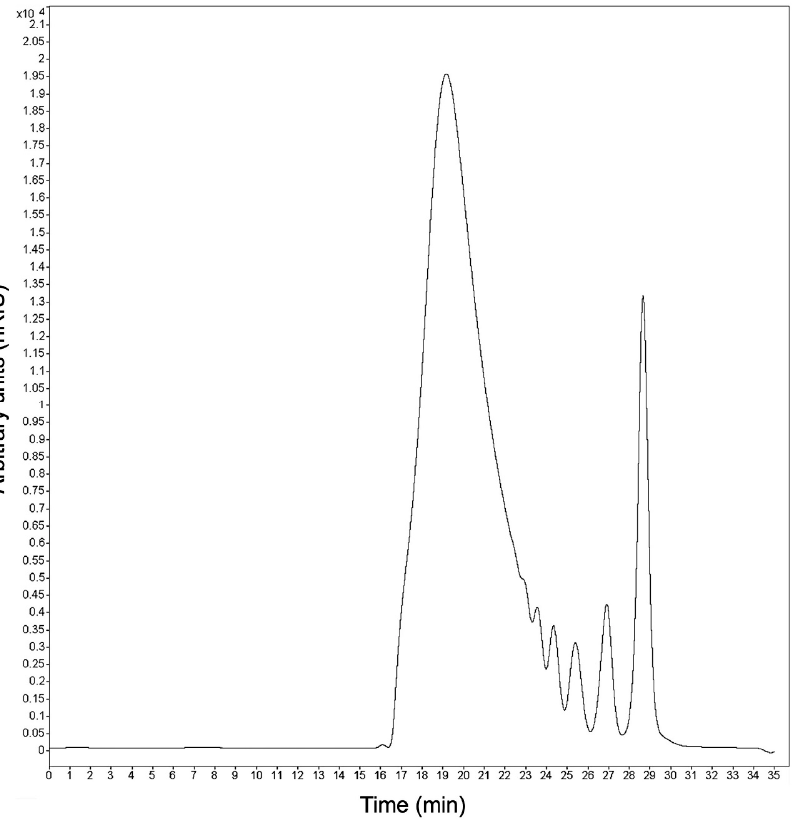
Figure 3. HPLC–size exclusion chromatography (SEC) chromatogram of initial agave fructan sample. Table 2. Profile of polymerization and mass distribution of commercial agave fructan, obtained with HPLC–SEC analysis.